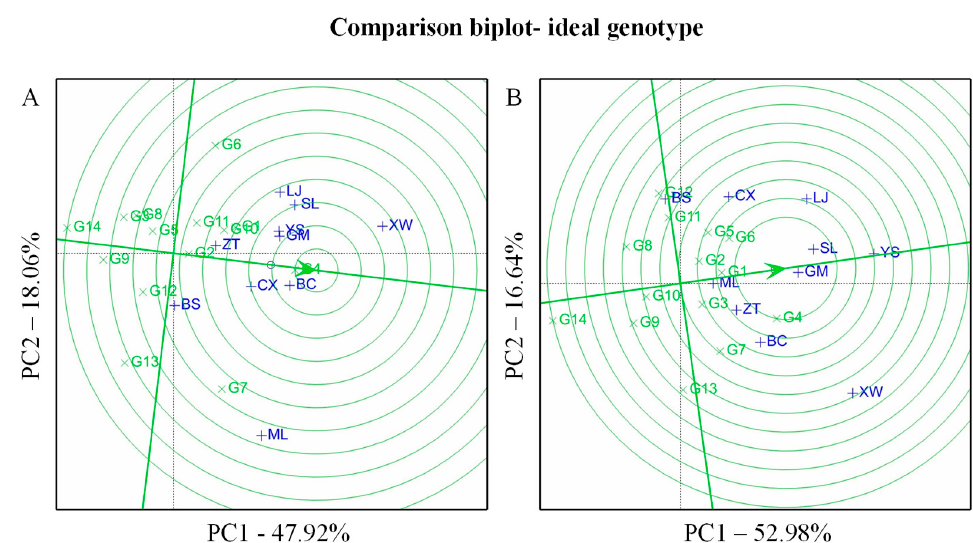
Figure 5. Visualization of ‘ideal genotype’ using GGE biplot. Concentric circles show the location of ideal genotypes. Genotypes closer to the ideal spot are ideal genotypes. GGE biplot of ideal hybrids